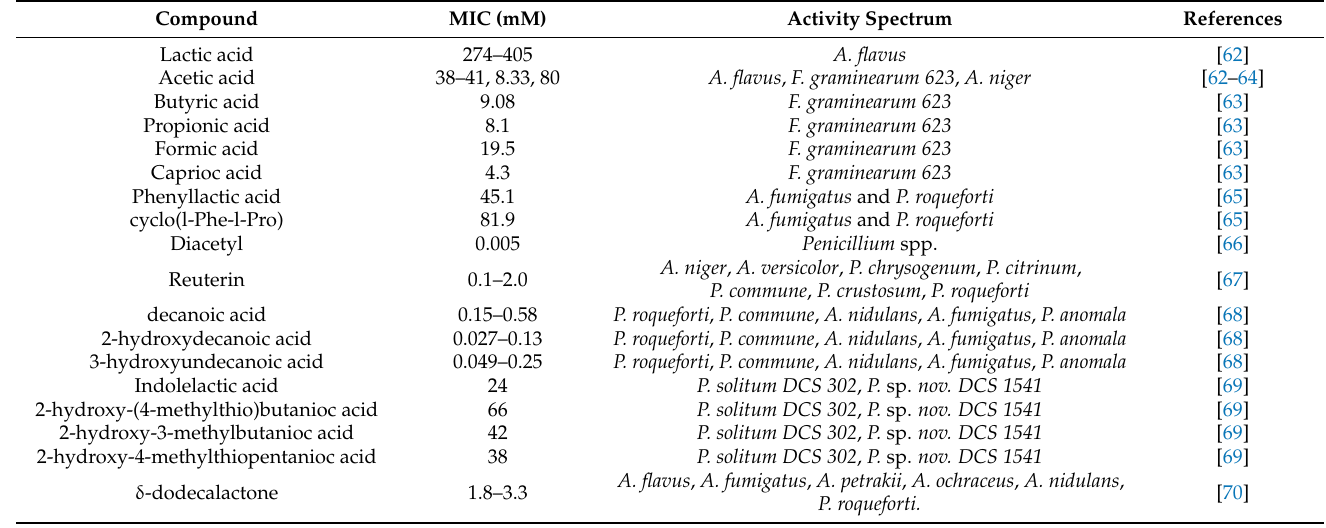
Table 3. Minimum inhibitory concentration (MIC) of several antifungal compounds based on